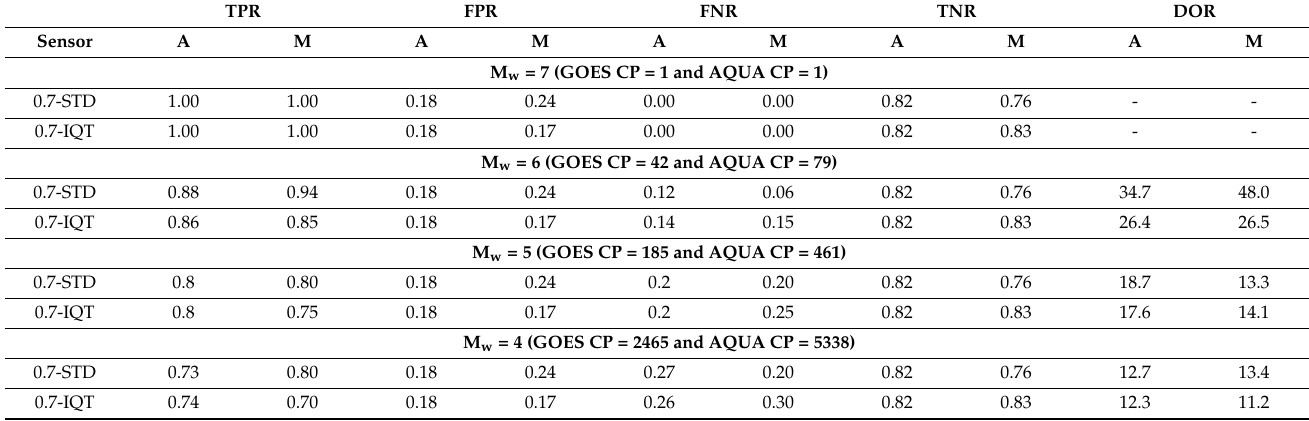
Table 6. Optimum Coefficients of The CM for Each M w.